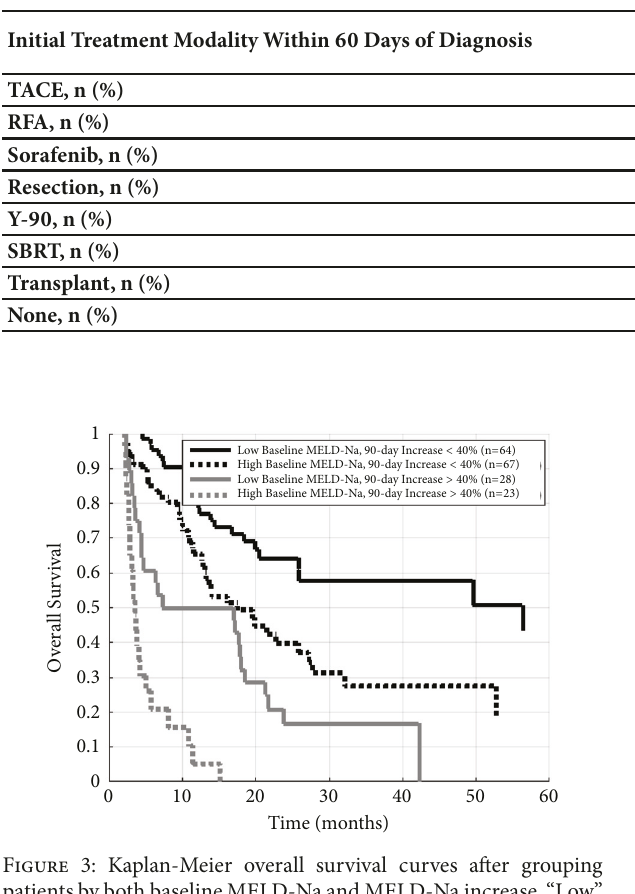
Table 3: Initial treatment modality grouped by MELD-Na increases cutoff of 40%. One patient had missing information regarding initial treatmentmodality.TACE=transcatheterarterialchemoembolization,RFA=radiofrequencyablation,Y-90=yttrium-90radioembolization, and SBRT = stereotactic body radiation therapy. Total percent may not add up to 100% due to rounding.